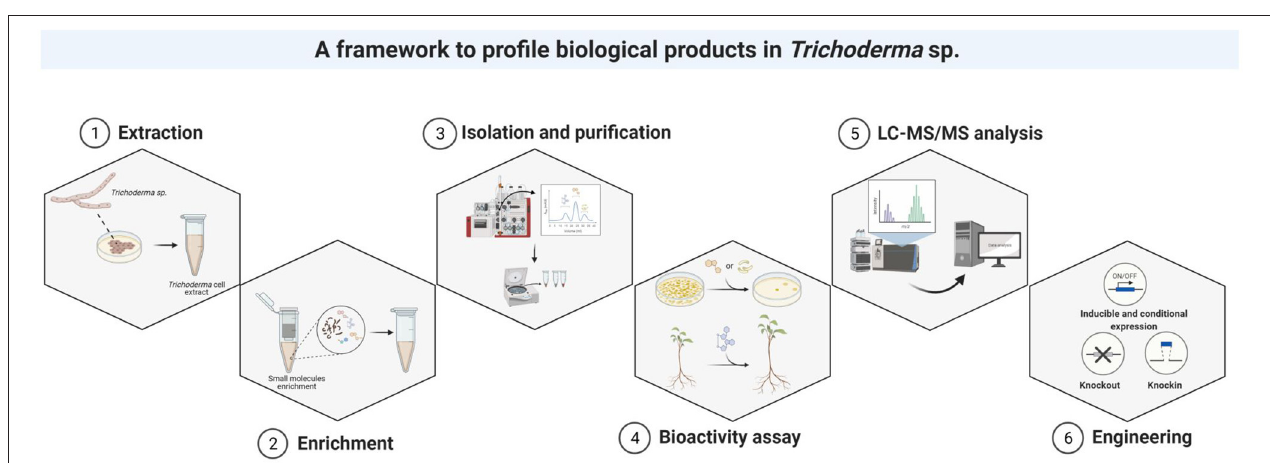
FIGURE 12 | The framework for the identification of natural products in Trichoderma species.